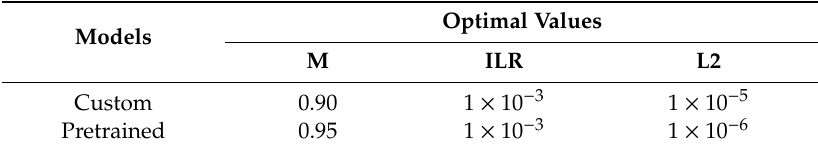
Table 4. Optimal values for the hyperparameters for the custom wide residual network (WRN) and pretrained convolutional neural networks (CNNs) obtained through the randomized grid search (M: momentum, ILR: initial learning rate, and L2: L2-weight decay).